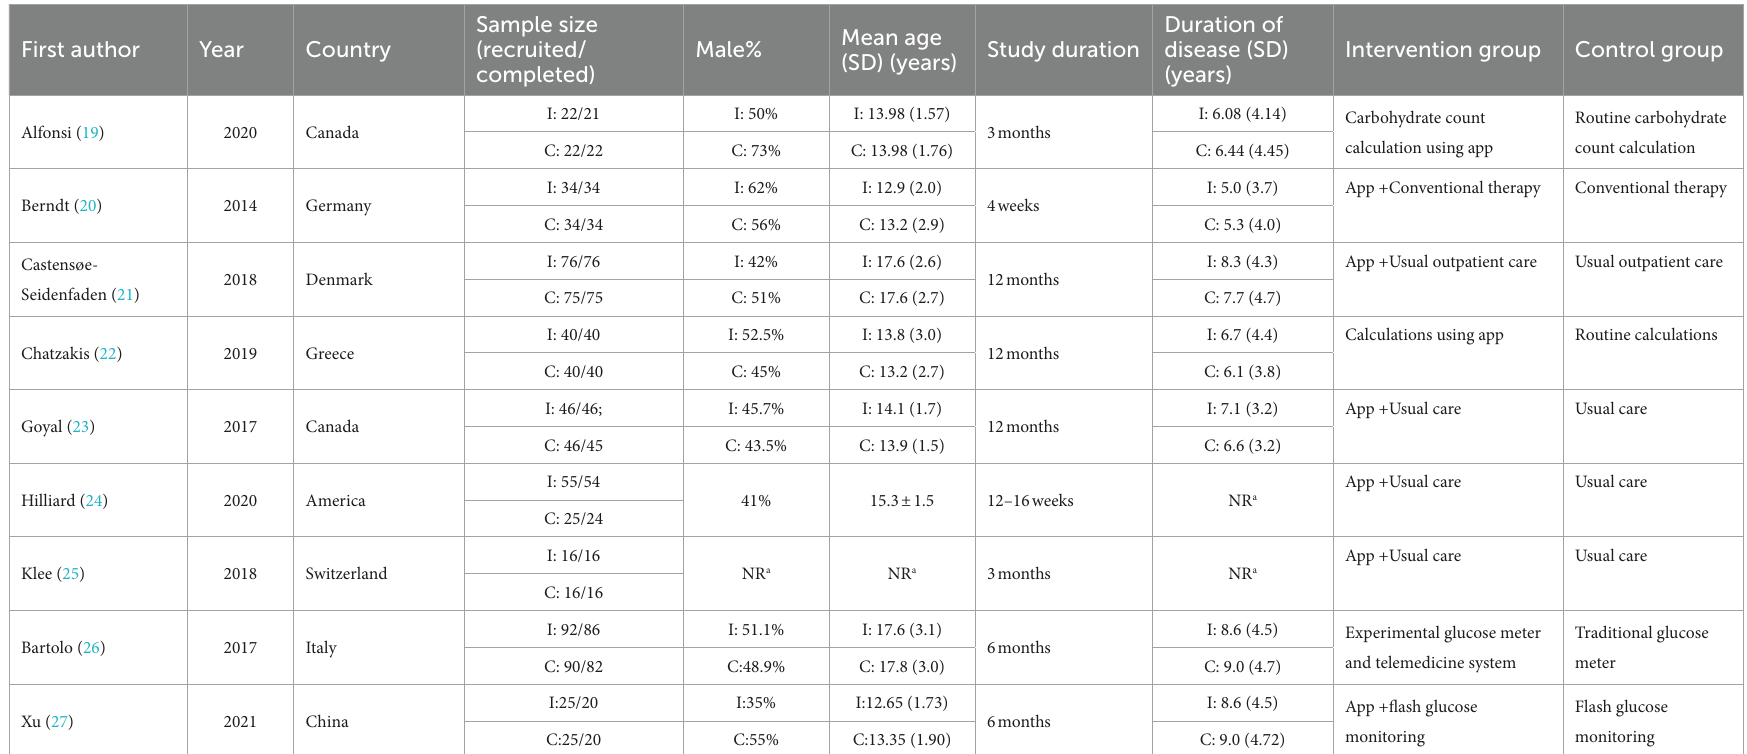
TABLE 1 Characteristics of the included